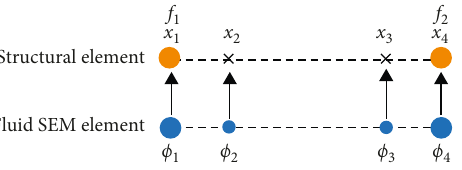
Figure 3: Energy-conservative mapping algorithm.